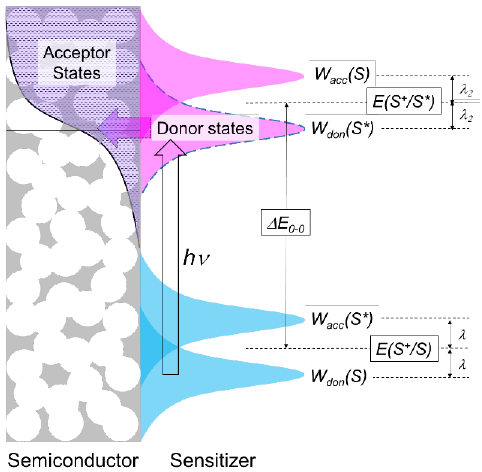
Figure 2. A Gerischer diagram illustrating electron injection from the photo-excited sensitizer into the acceptor states within titania [10–12].